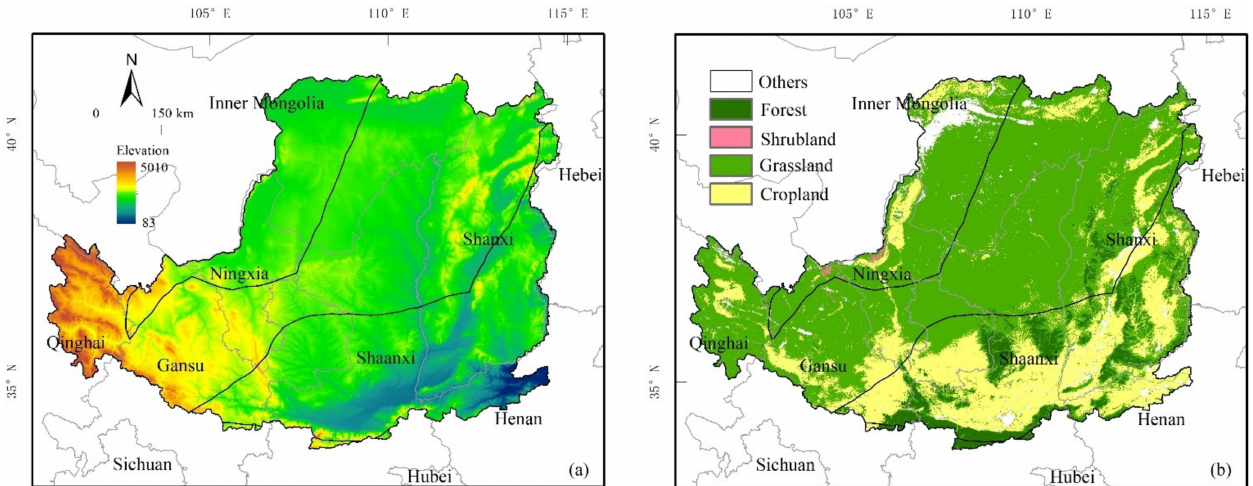
Figure 1. Map outlining the geographic location ( a ) and vegetation types ( b ) of the Loess